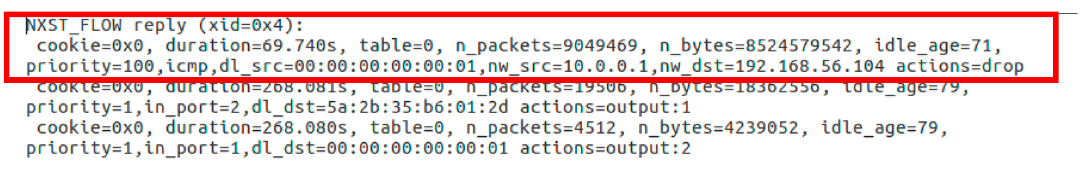
Figure 16. Scenario III— Hosts 2 and 3 Rate During a DDoS Attack Based on Large Size Packets.